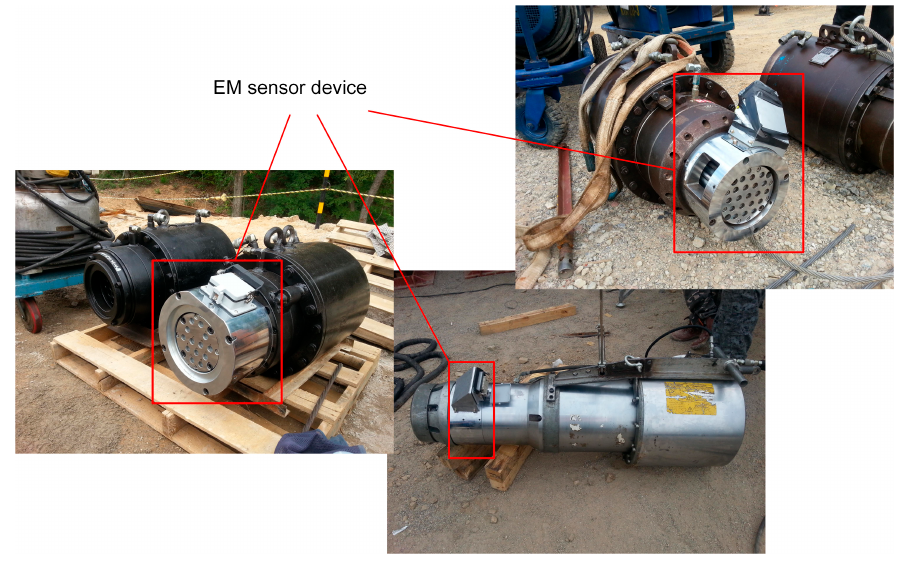
Table 2. Hydraulic jacks used for the prestressing of girders and measurement of the prestress force distribution.